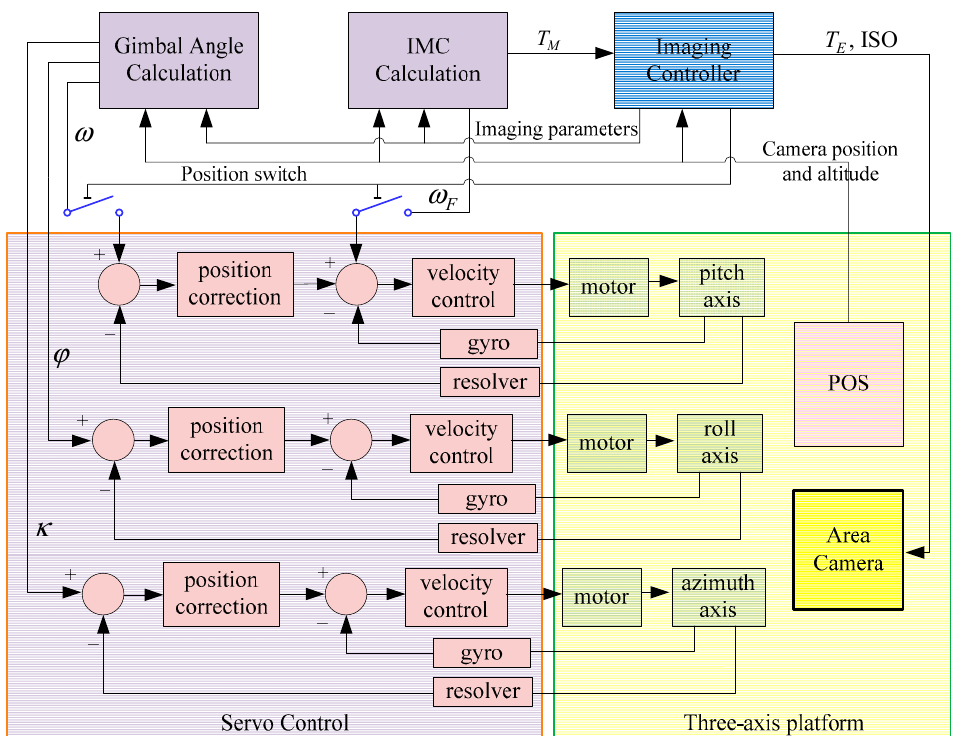
Figure 2. Block diagram of the imaging control.